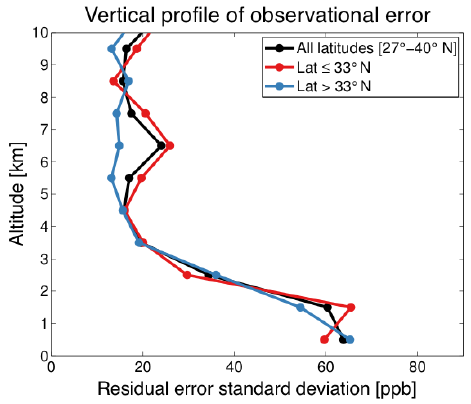
Figure 3. Residual standard deviation (RSD) of the difference be- tween SEAC 4 RS methane observations and the GEOS-Chem model with prior emissions, for 1km altitude bins. The RSD defines the observational error standard deviations for the inversion as de- scribed in the text. Values are shown for two latitudinal